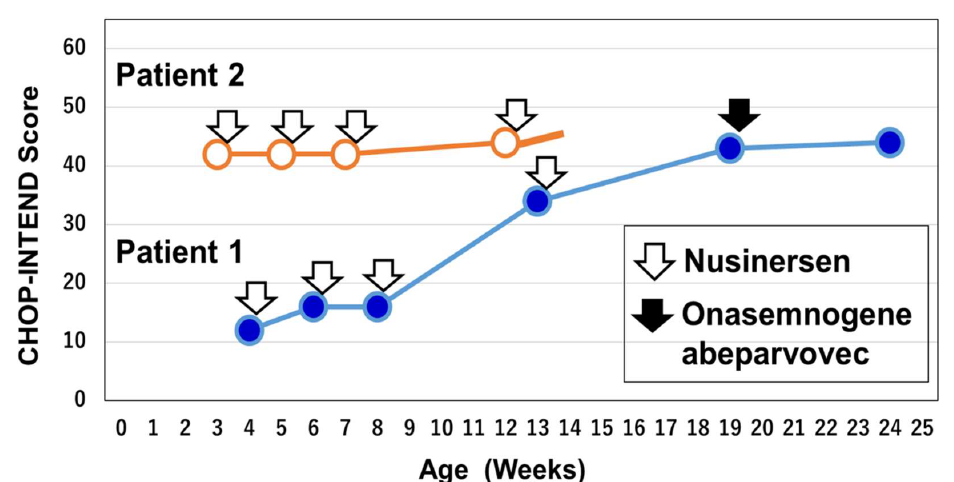
Figure 2. MLPA and ddPCR analyses of patients identified by SMA-NBS. Multiplex ligation-de- pendent probe amplification (MLPA) and droplet digital PCR (ddPCR) showed that both patients carried homozygous deletion of SMN1 exons 7 and 8 and two copies of SMN2 exons 7 and 8. They also showed homozygous deletion of NAIP exon 5 on MLPA analysis. NAIP : the neuronal apoptosis inhibitory protein gene.